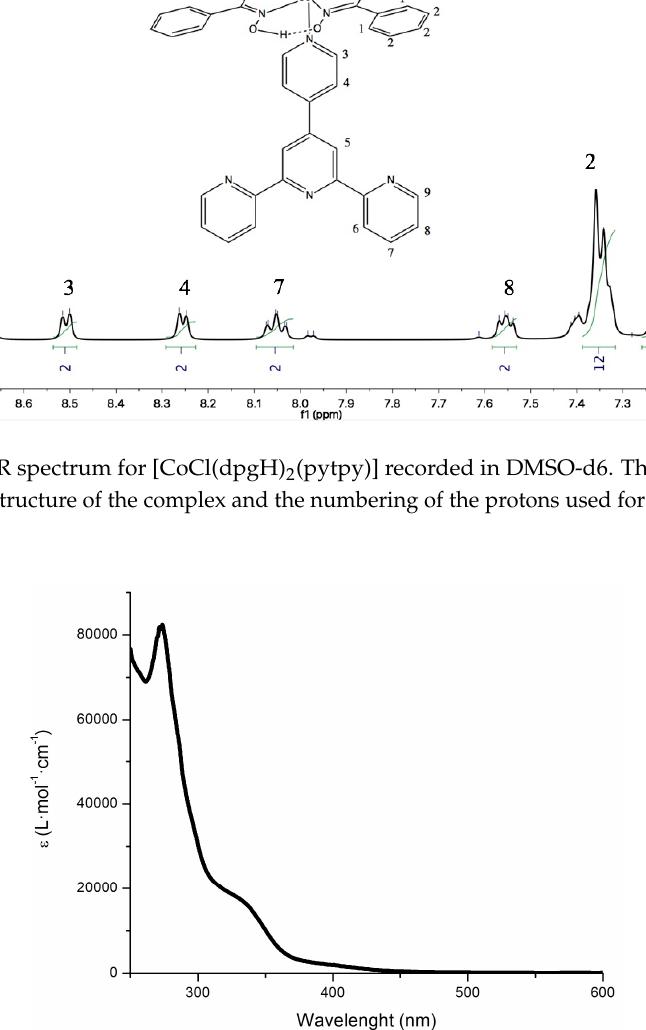
Figure 3. UV–Vis spectra for [CoCl(dpgH) 2 (pytpy)] recorded in